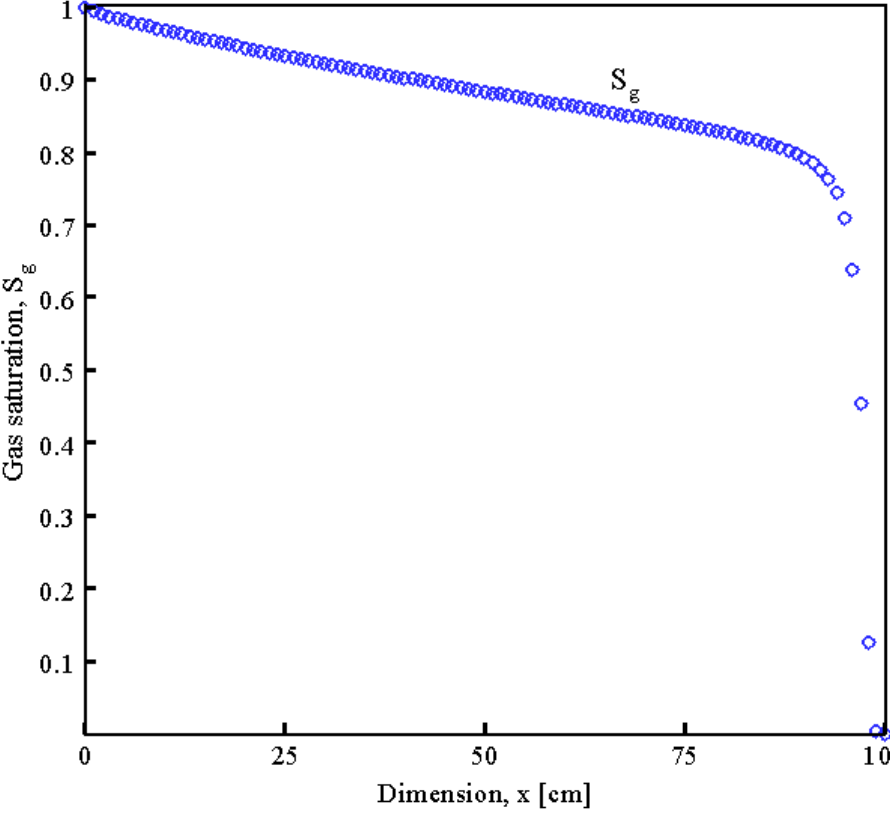
Figure 3. Gas saturation S g versus dimension x at constant thermobaric conditions in the computational domain.